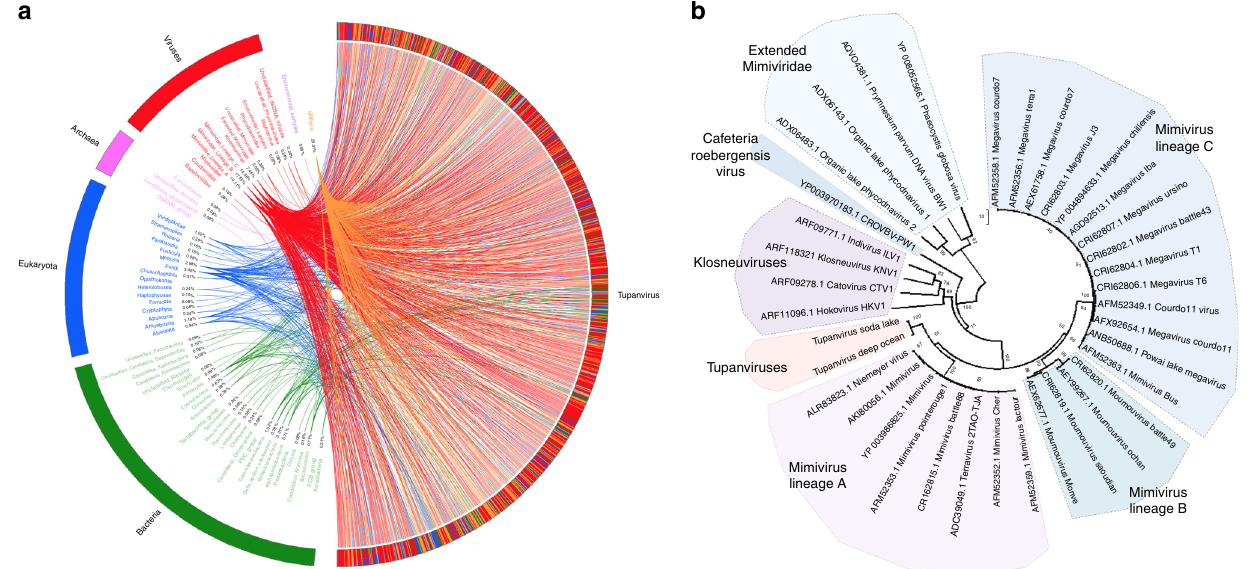
Fig. 3 Tupanvirus soda lake rhizome and Mimiviridae family B DNA polymerase tree. a The rhizome shows that most Tupanvirus soda lake genes have mimiviruses as best hits. However, correspondence among Tupanvirus and Archaea , Eukaryota , Bacteria and other viruses was also observed. b Family